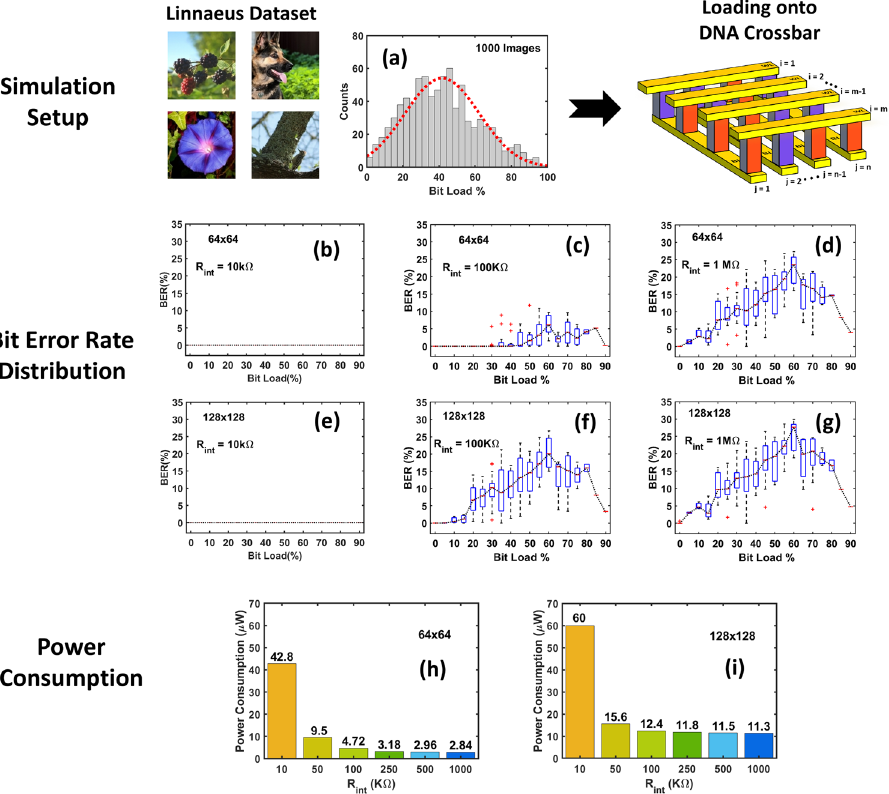
Figure 8. Storage application results for a simulation setup where 1000 images from the Linnaeus dataset are loaded onto 64 × 64 and 128 × 128 crossbar arrays. ( a ) distribution of bit load (%) in the dataset, ( b – g ) distributions of bit error rates for each bit load (%) vs. array size and interconnect resistance, ( h , i ) average power consumed as a function of R int for 64 × 64 and 128 × 128 arrays. Note that the read-out accuracy is ~ 100% for interconnect resistances below 100 kΩ and 50 kΩ for 64 × 64 and 128 × 128 arrays